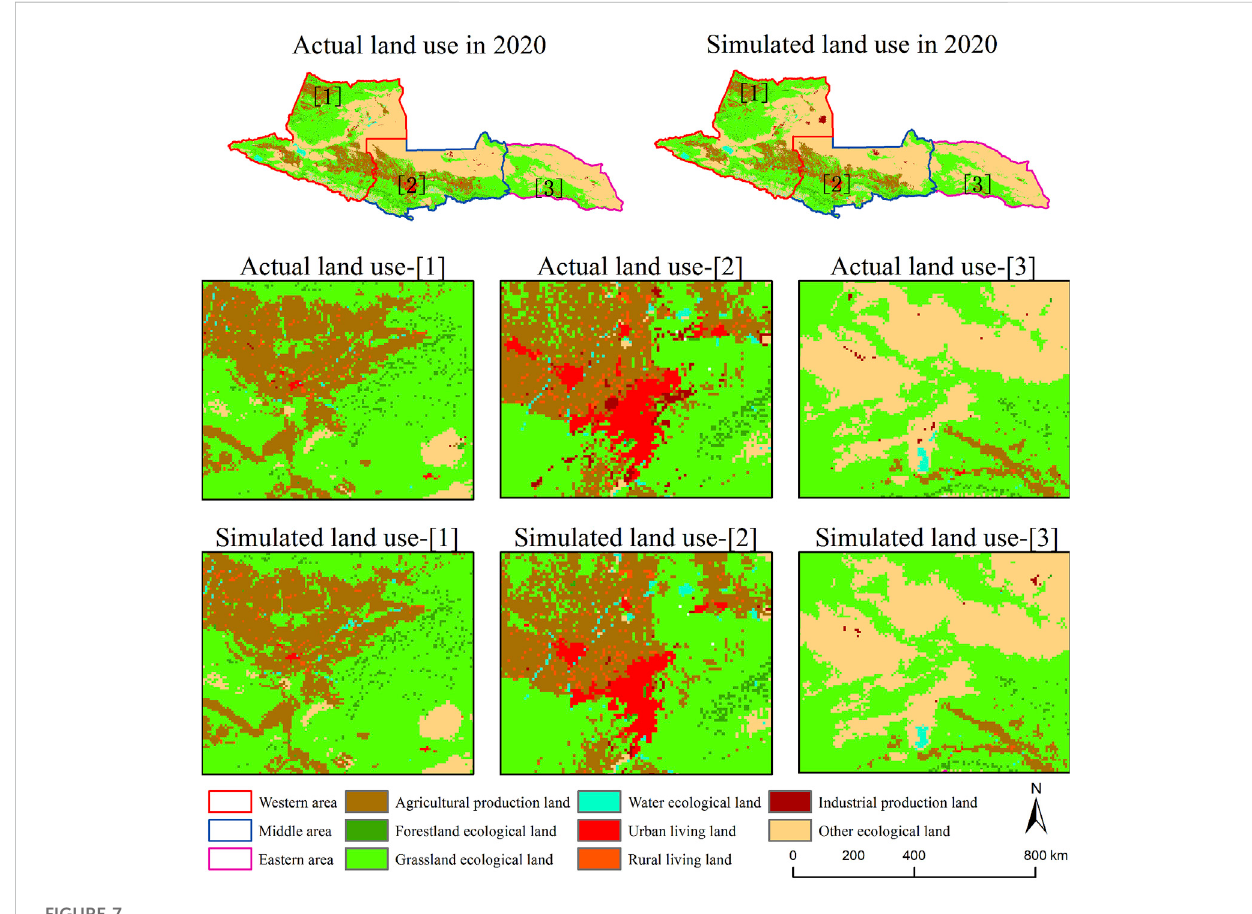
Comparison of simulated land use and actual land use in